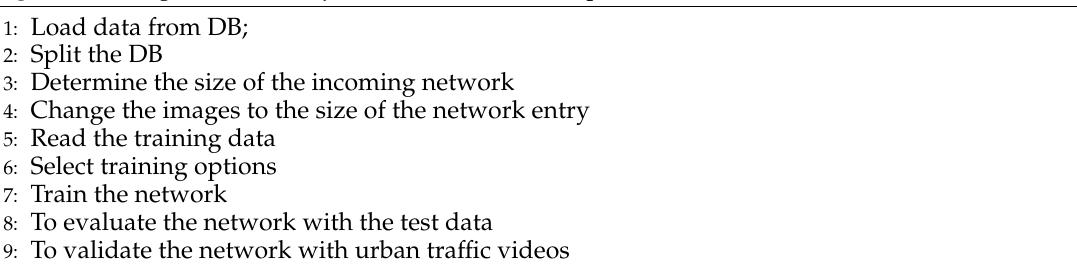
Algorithm 1 Algorithm for Object Detection of the Proposed Solution.